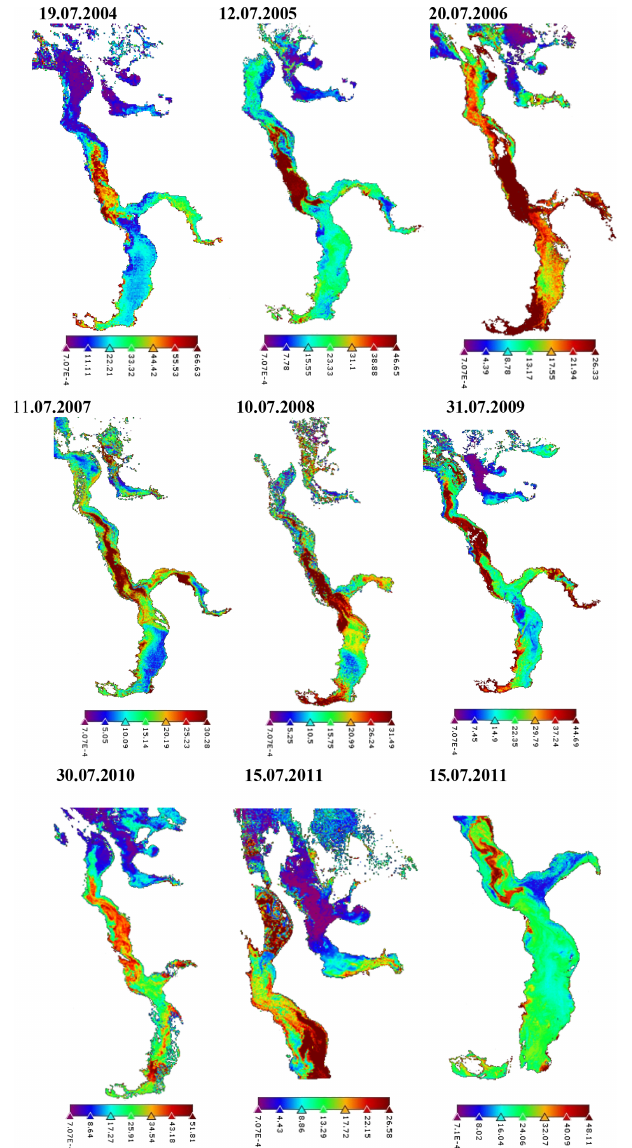
Figure 5. CHL distribution, mgm − 3